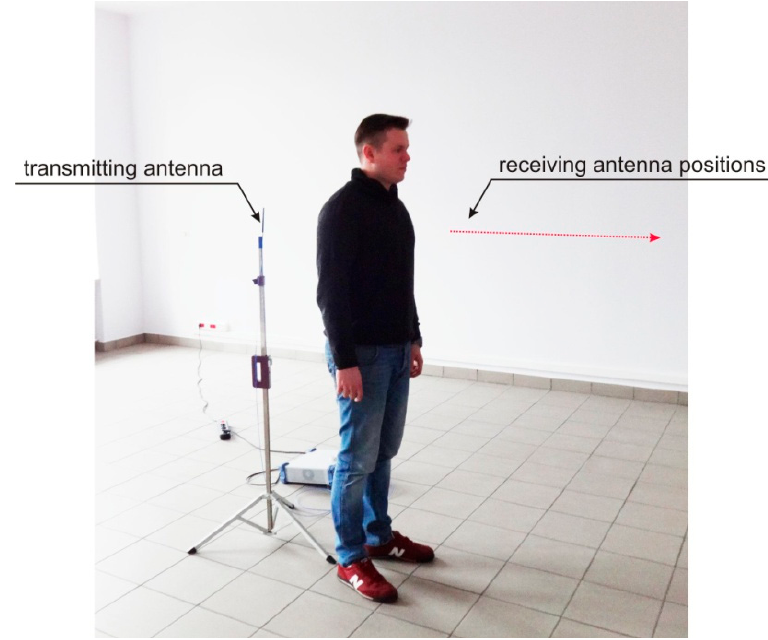
Figure 13. Setup for experimental measurements.